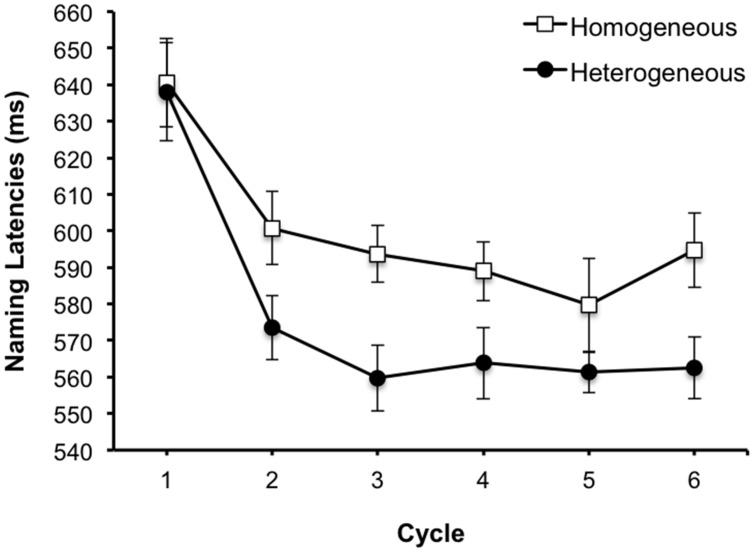
Mean correct basic-level naming latencies as a function of context and cycle in the blocked cyclic paradigm. Error bars represent 95% CIs calculated per Cousineau’s (2005) method.